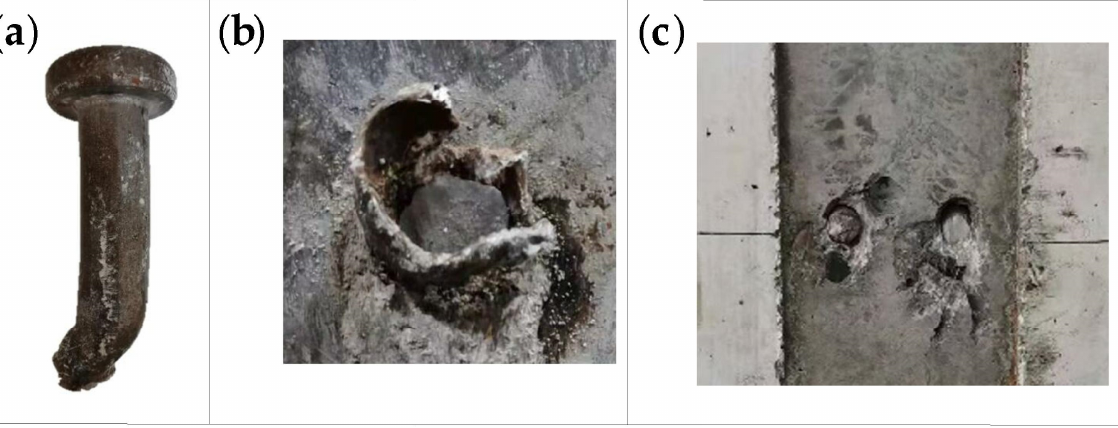
Figure 17. Static test failure mode of the push-out specimen: ( a ) stud; ( b ) welding ring; ( c ) concrete. Table 8. Comparison between the simulated and experimental result.